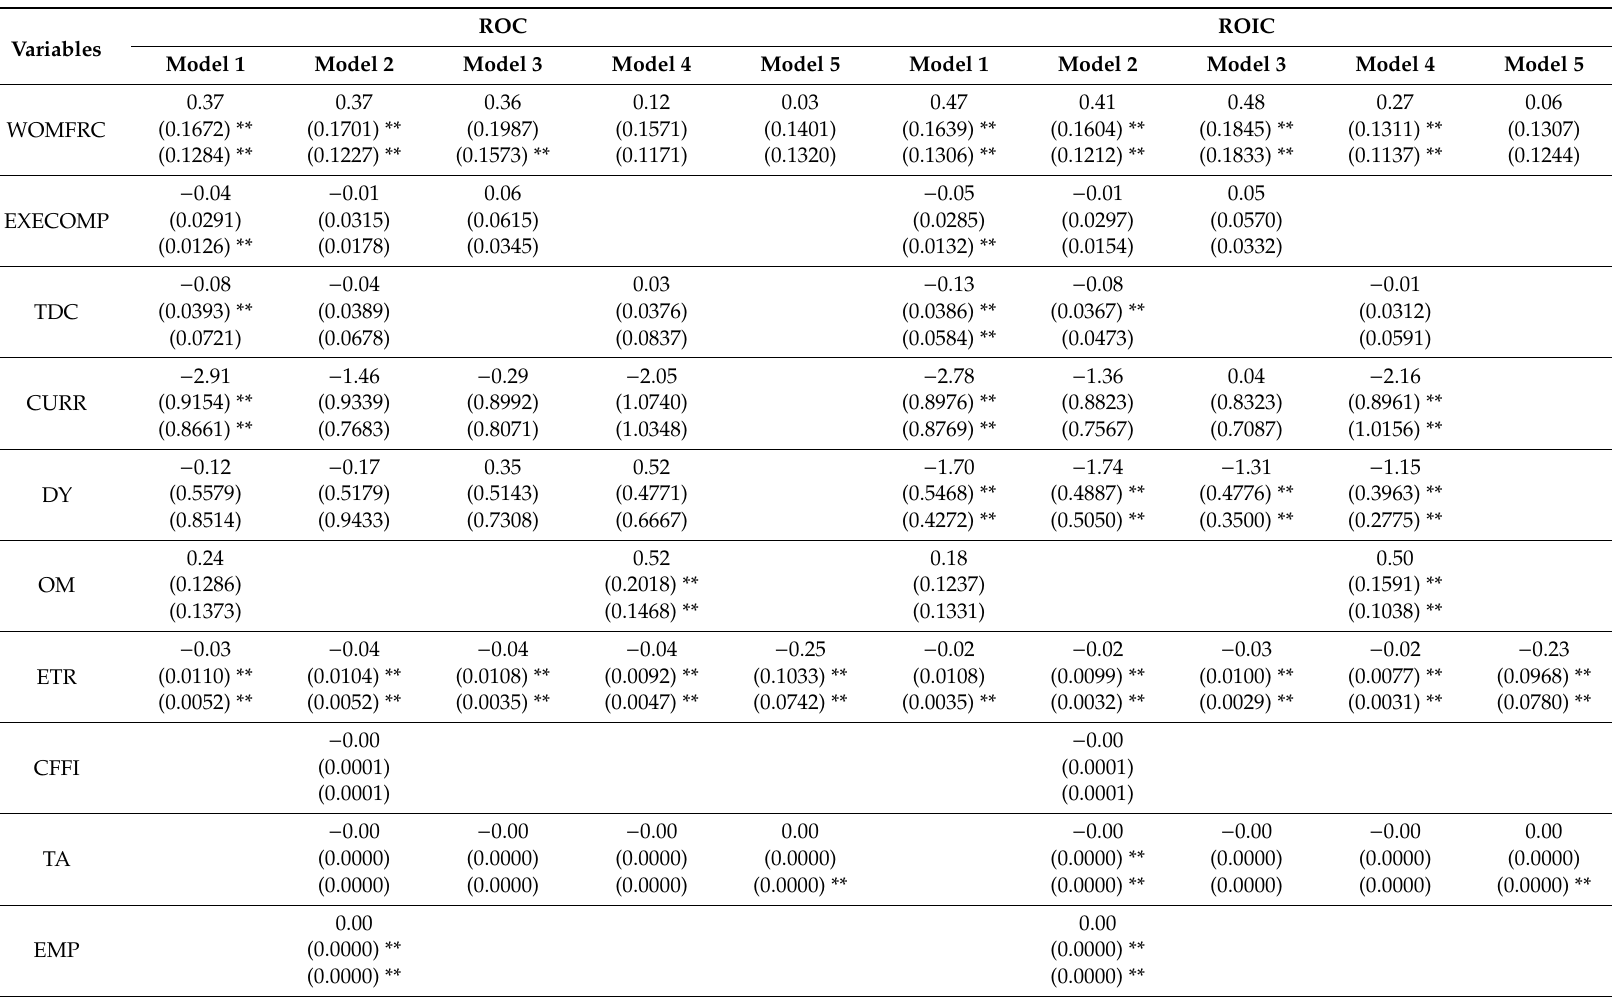
Table 11. The outcomes of panel data pooled regression models regarding the influence of water, waste, and energy consumption, alongside firm and corporate governance-specific variables, on return on capital and return on invested